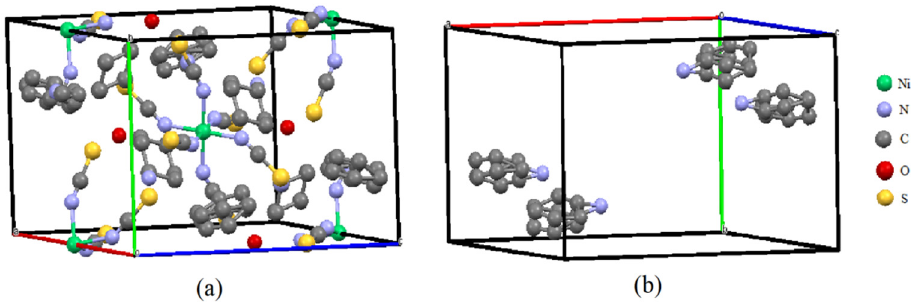
Figure 6. X-ray powder diffraction patterns: ( A ) the simulation based on the disordered structure of the doubly attached rings, ( B ) the simulation by removing the extra carbon atoms due to the disorder in the doubly attached rings, and ( C ) the experimental for (C 6 H 11 NH 3 ) 4 [Ni(NCS) 6 ] · 2H 2 O.